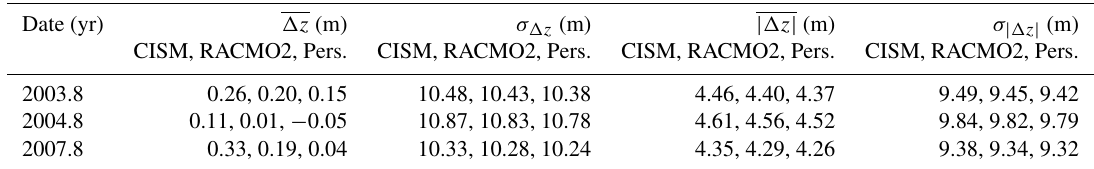
Table 1. Whole-ice-sheet metrics for model (CISM) vs. ICESat observations (ICESat-model) for the SMB-only simulation. For reference, results for the idealized simulations, “RACMO2-SMB-only” (RACMO2) and “persistence” (Pers.) are also shown. Date (yr) (cid:49)z (m) σ (cid:49)z (m) CISM, RACMO2, Pers. CISM, RACMO2, Pers.